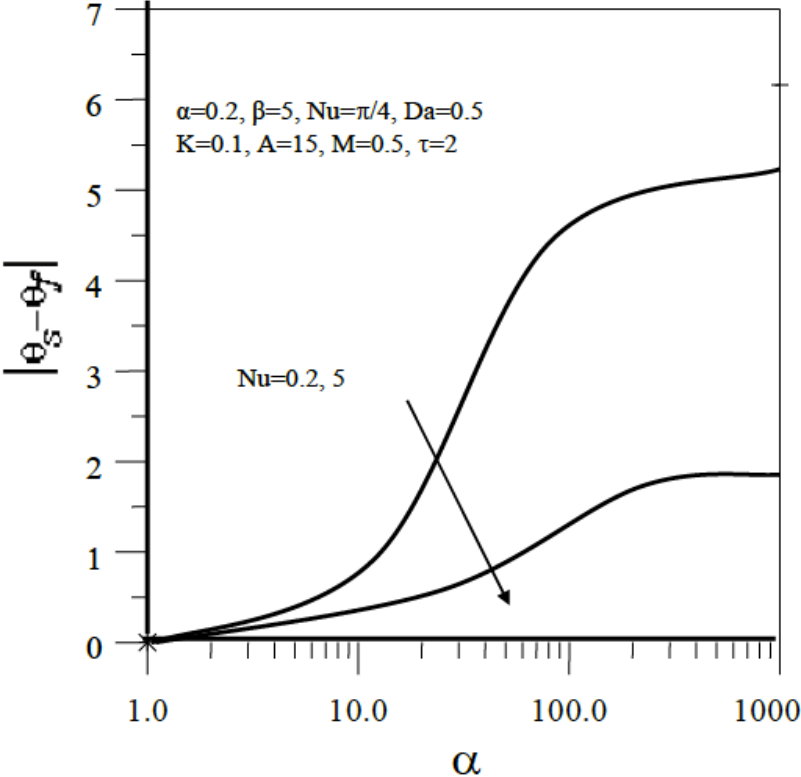
(cid:12) (cid:12) (cid:12) θ s − θ f (cid:12) ) against thermal diffusivity ratio ( α ), presented